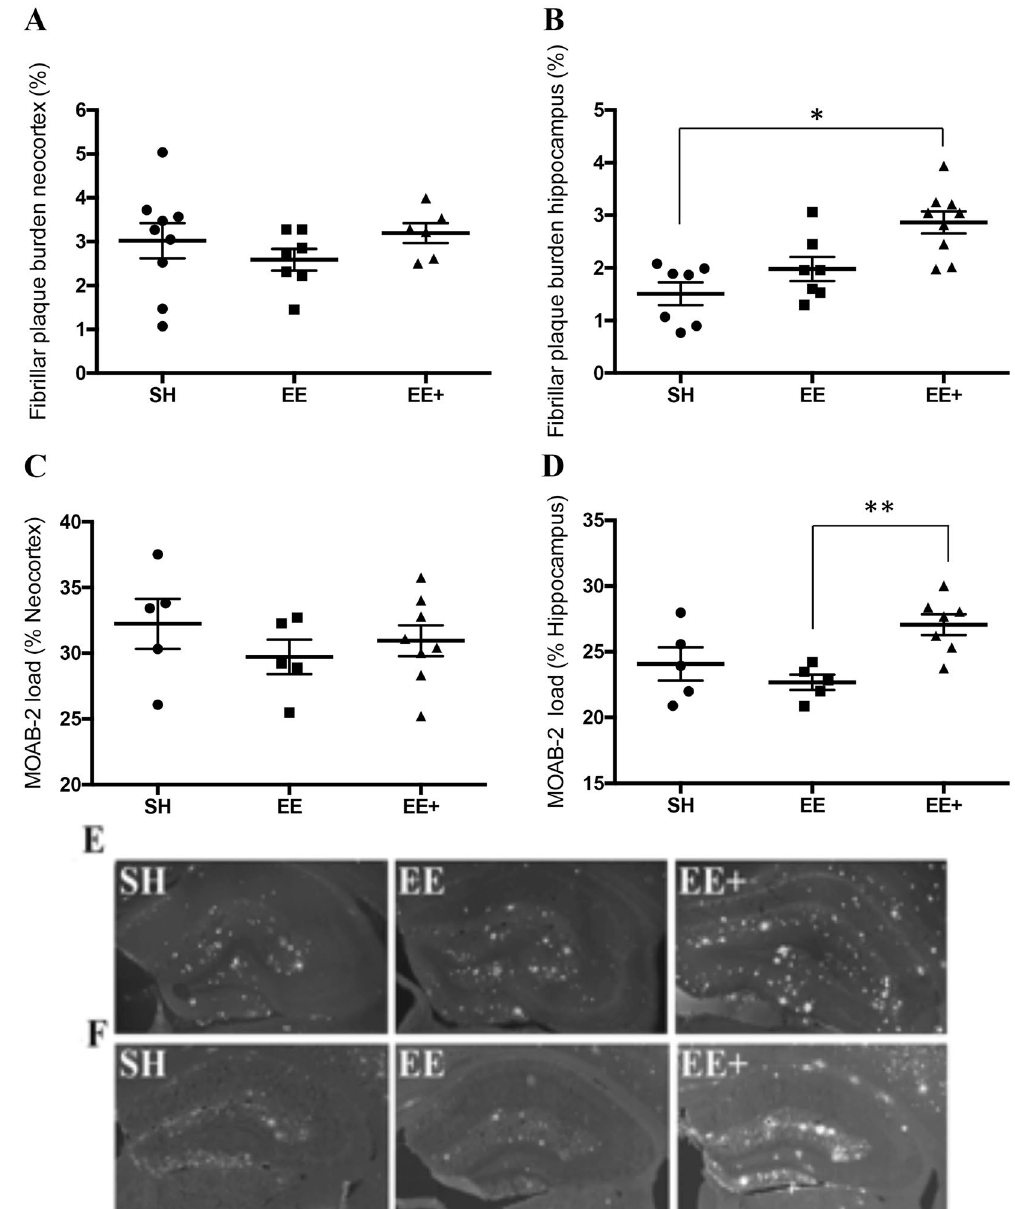
Figure 1. A β plaque load in neocortex and hippocampus in APP/PS1 mice exposed to differential housing. ( A ) Thioflavin-S staining of fibrillar and dense core A β plaques demonstrated no significant difference in plaque load in neocortex between the housing groups, F (2, 19) = 0.78, p = 0.47. ( B ) A significant effect of housing was detected on Thioflavin-s plaque load in the hippocampus, F (2, 19) = 4.80, p = 0.02. Bonferroni adjusted post hoc tests revealed APP/PS1 mice housed in EE + had higher hippocampal A β fibrillar plaque burden when compared to those in SH ( p = 0.02). ( C ) MOAB-2 immunolabelling demonstrated no significant differences across housing groups in A β 1-42 load, F (2, 18) = 0.65, p = 0.54. ( D ) A significant effect of housing condition was detected on hippocampal MOAB-2 load, F (2, 18) = 7.78, p = 0.005. Bonferroni adjusted post hoc tests showed EE + mice to have a significantly higher hippocampal MOAB-2 load relative to mice in SH. SH ( n = 9), EE ( n = 7), EE + ( n = 6) * p < 0.05, ** p < 0.01, *** p < 0.001. ( E ) Representative 10x Thioflavin-s staining in hippocampus of APP/PS1 mice for each housing group. ( F ) Representative 10x MOAB-2 staining in hippocampus of APP/PS1 mice for each housing